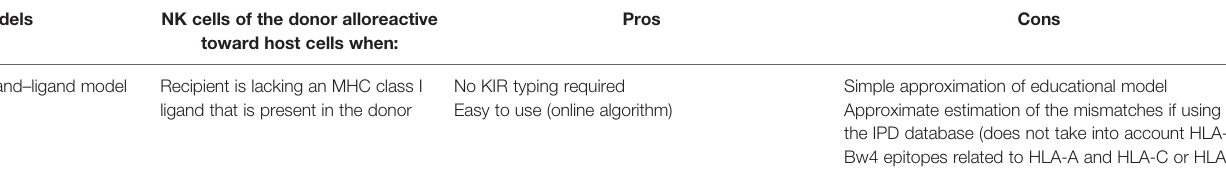
TABLE 5 | Pros and cons of scoring strategies for NK alloreactivity assessment.